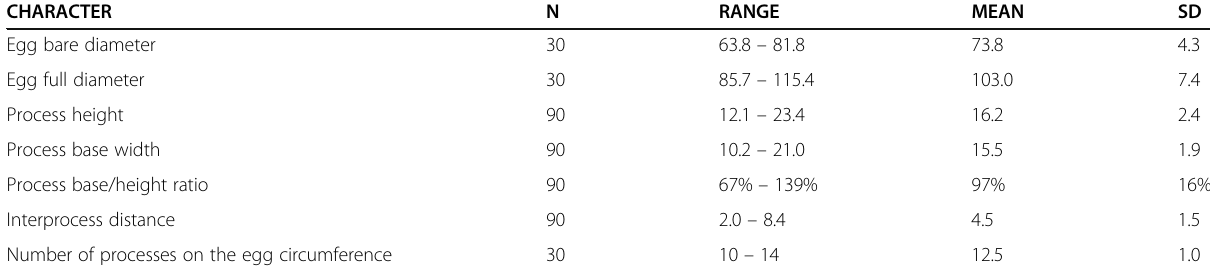
Table 9 Measurements [in μ m] of selected morphological structures of the eggs of Macrobiotus pseudopallarii sp. nov. from Montenegro (ME.007) mounted in Hoyer ’ s medium (N – number of eggs/structures measured, RANGE refers to the smallest and the largest structures among all measured specimens; SD – standard deviation)